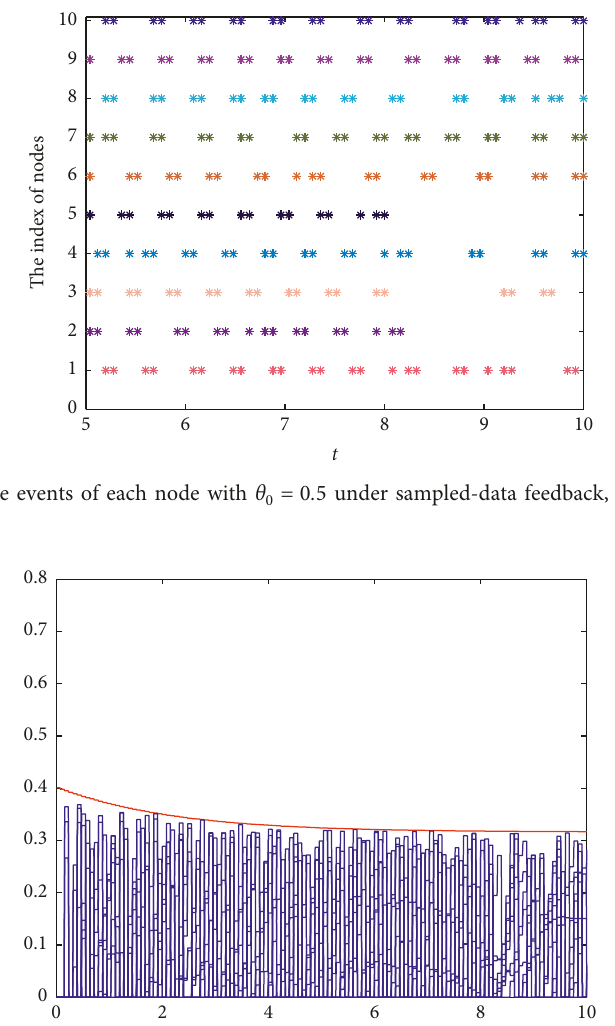
� 0 . 5 under sampled-data feedback, i � 1 , 2 , ... , 10. 0